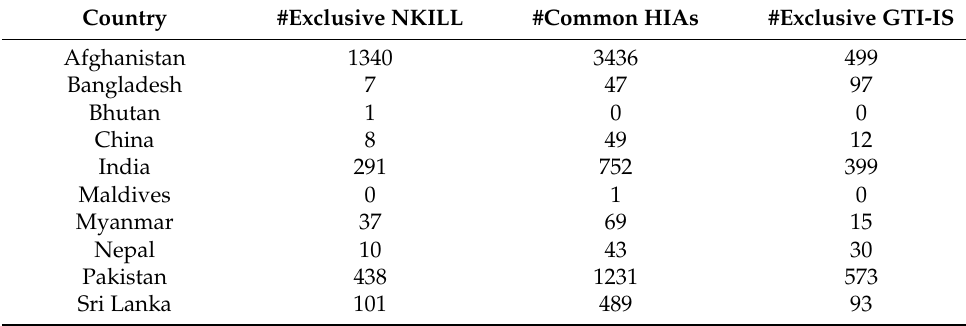
Table 4. Country-wise HIAs identified by nkill and GTI-IS attribute.